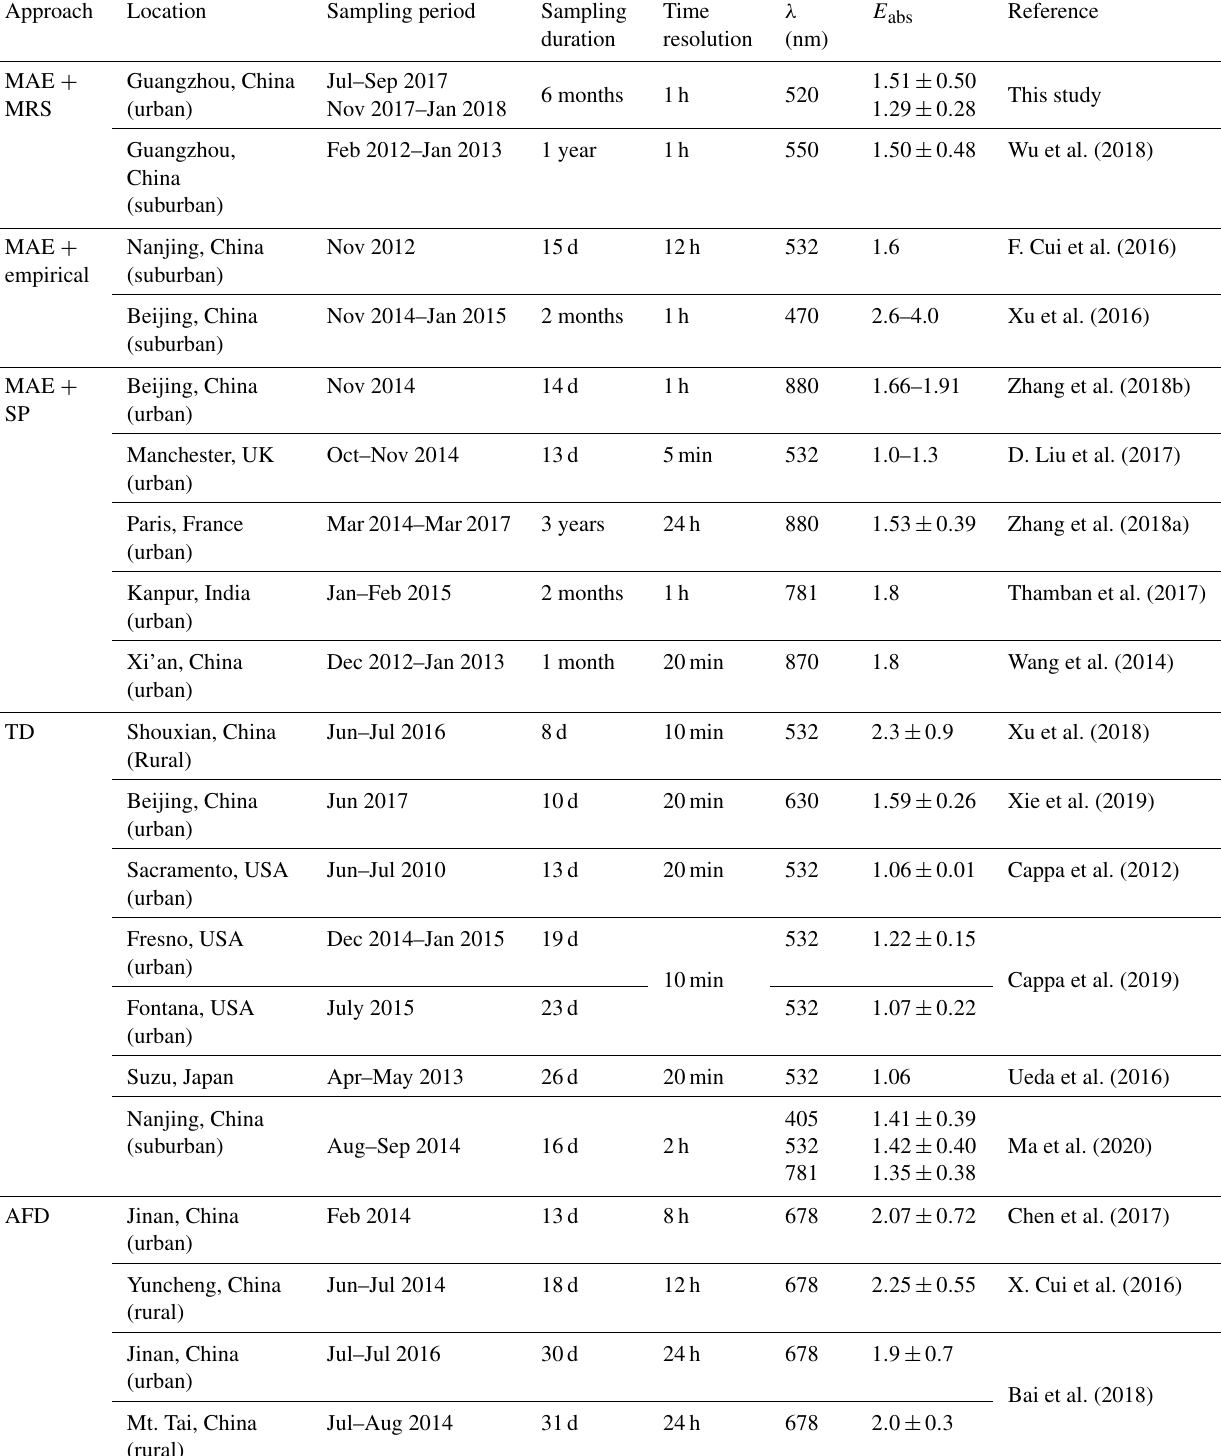
Table 2. Comparisons of E abs measurements in various field studies.